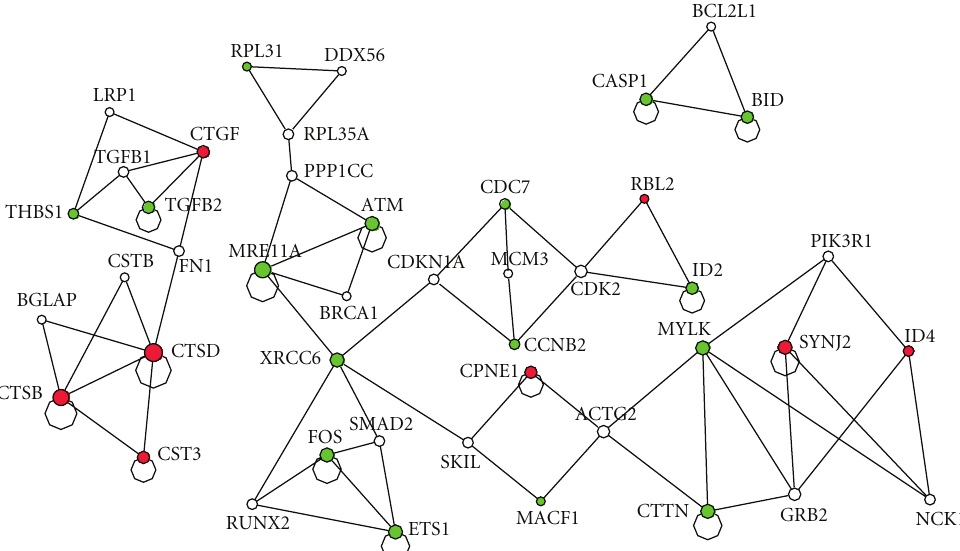
Figure 3: The cliques or near cliques from the cancer pathway related network G p . The up-and downregulated genes are shown in red and green,